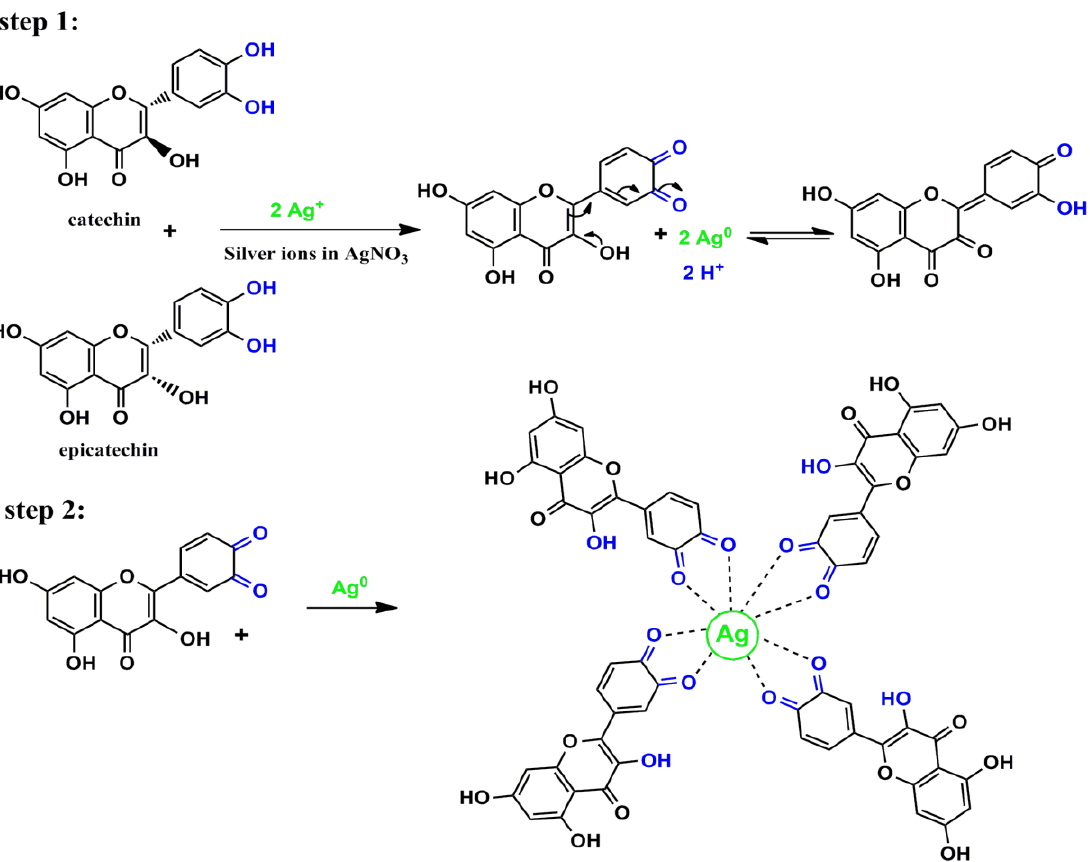
Figure 5. Proposed mechanism for the Ag NP production throughout silver ion–PPHL interactions.